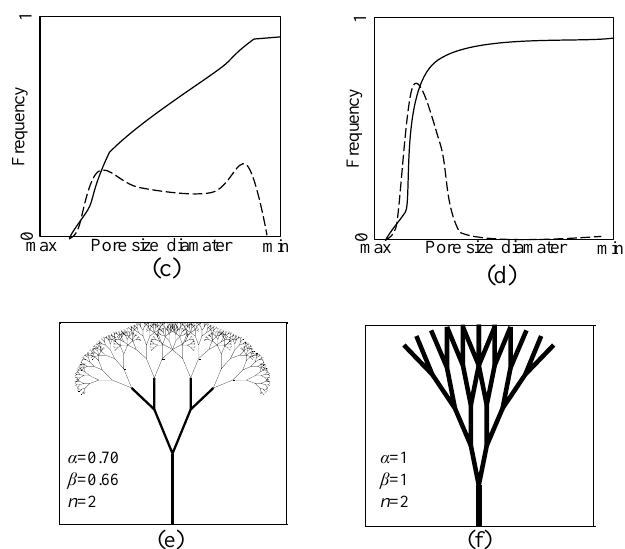
Figure 1. Relationship between pore structure and fractal network in tight and normal matrix. ( a ) and ( c ) shows the schematic of mercury injection features and pore size distribution for typical tight matrix, ( b ) and ( d ) shows the schematic of mercury injection features and pore size distribution for normal matrix. ( e ) represents the fractal network for tight matrix. ( f ) represents the fractal network for normal matrix which has less branches and larger pores.